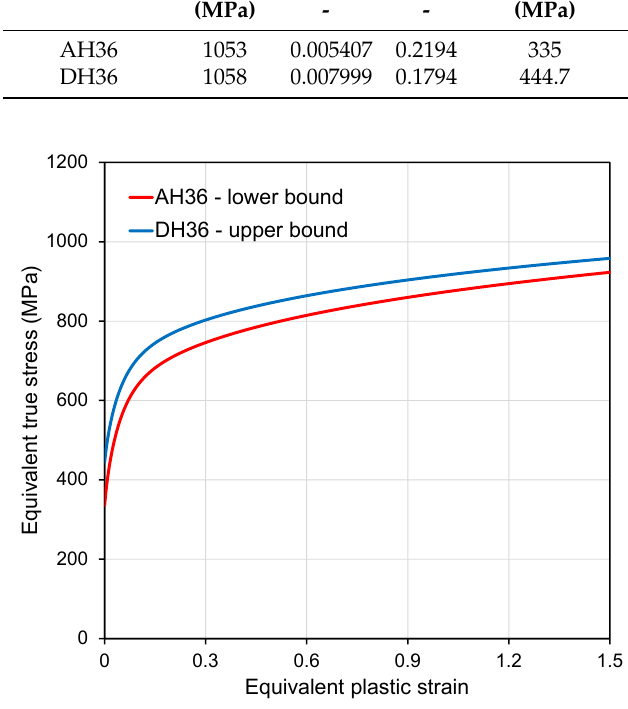
Figure 3. Hardening curves of AH36 and DH36 grade steels [30].